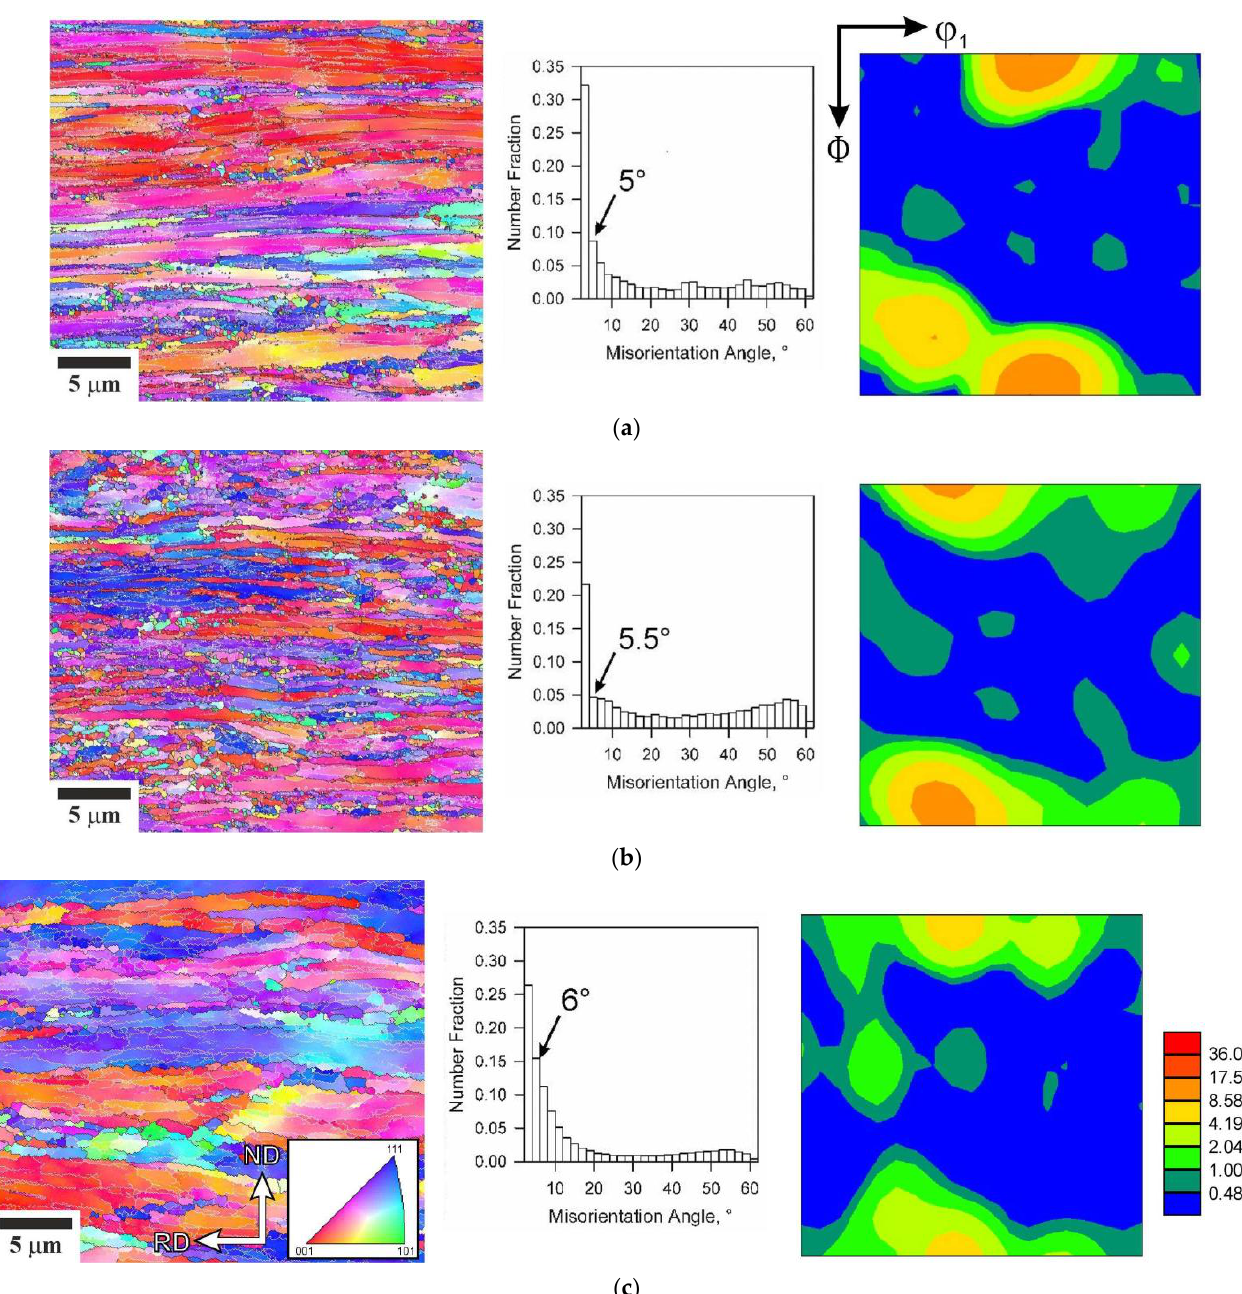
Figure 1. Microstructures developed in an HSLA steel subjected to tempforming at 873 K ( a ), 923 K ( b ) and 973 K ( c ) along with grain/subgrain misorientation distributions and sections of orientation distribution functions at φ 2 = 0°. Colors correspond to the crystallographic direction along the normal direction (ND). The black and white lines indicate high- angle boundaries (θ ≥ 15°) and low - angle sub- boundaries (2° ≤ θ < 15°), respectively. Arrows on the misorientation distributions indicate an average sub-boundary misorientation.